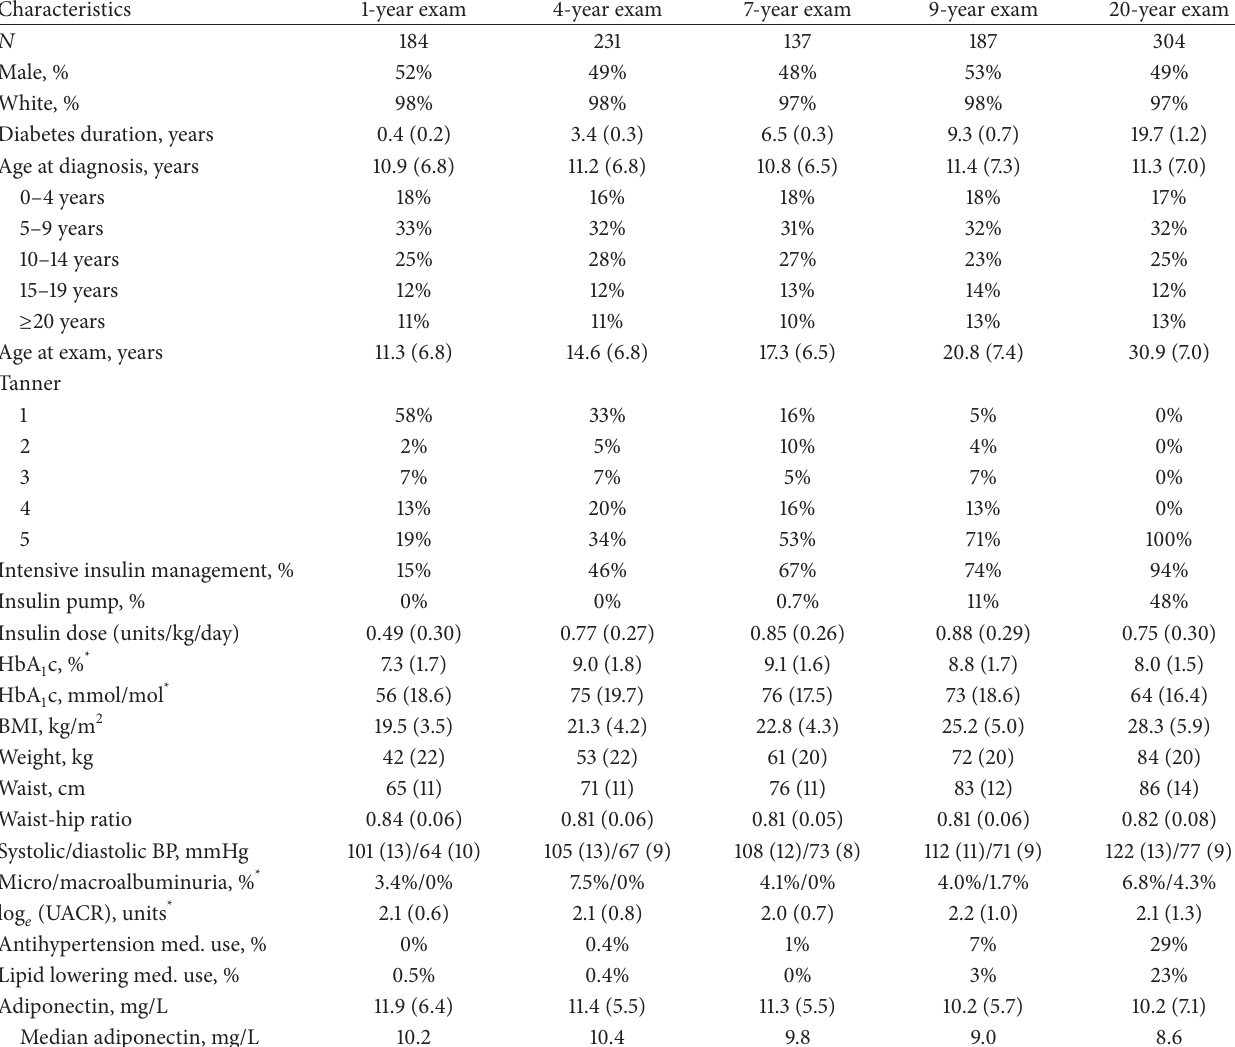
Table 1: Characteristics for Wisconsin Diabetes Registry Study participants with adiponectin